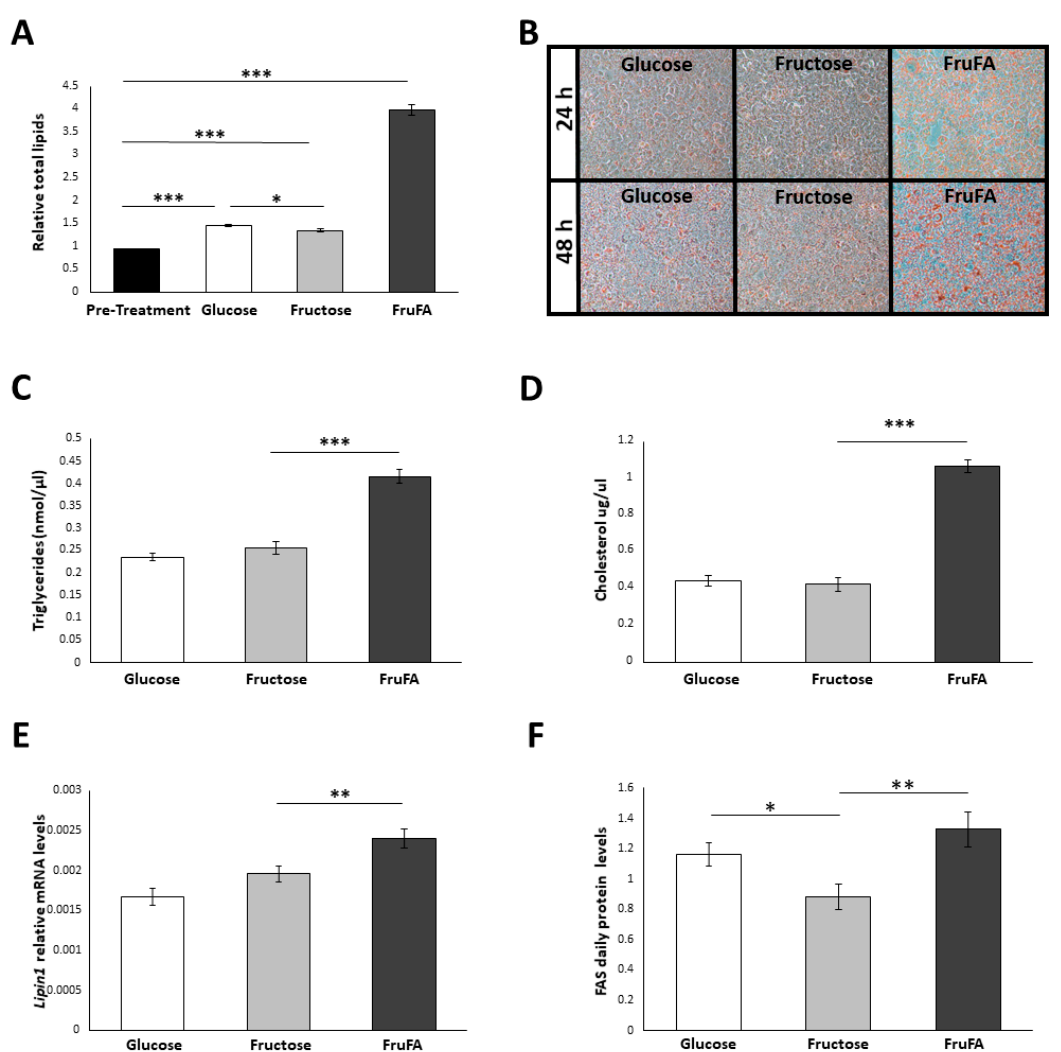
Figure 1. Effect of fructose and fructose-induced steatosis on lipid metabolism in AML-12 hepa- tocytes . ( A ) Relative lipid accumulation after 48 h or in pre-treated AML-12 hepatocytes (n = 21 per group). ( B ) Fluorescence microscopy images showing lipid content stained by Oil Red O staining